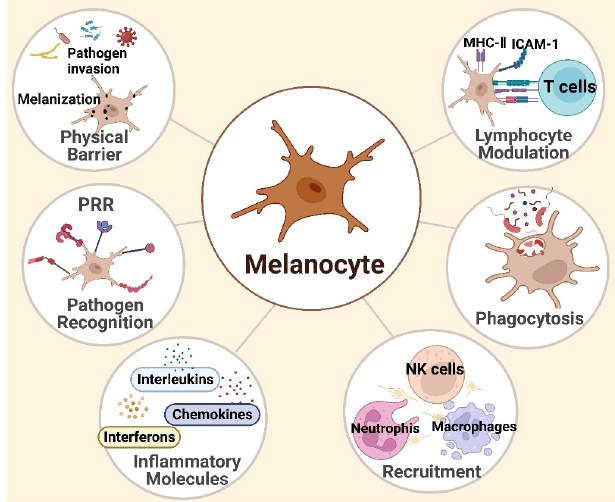
Figure 1. Melanocytes in skin immunity. Melanocytes located strategically in the epidermis act as an external barrier to pathogenic threats. They express many different pattern recognition receptors (PRRs) and mobilize their innate immune function and initiate the inflammatory cascade after activating PRRs. Subsequently, melanocytes trigger signal pathways and secrete interferons (such as IFN- α and IFN- β ), inflammatory cytokines, and chemokines, such as interleukin (IL)-1 β , IL-6, IL-10, IL16, TNF- α , CCL2, CCL20, CXCL8, and CXCL12. On the other hand, melanocytes are capable of phagocytosis of pathogens, then processing and presenting antigen to CD4+ T-cell clones in an antigen-specific and MHC class II-restricted manner, indicating that melanocytes function as nonprofessional antigen-presenting cells. The figure was created using BioRender.